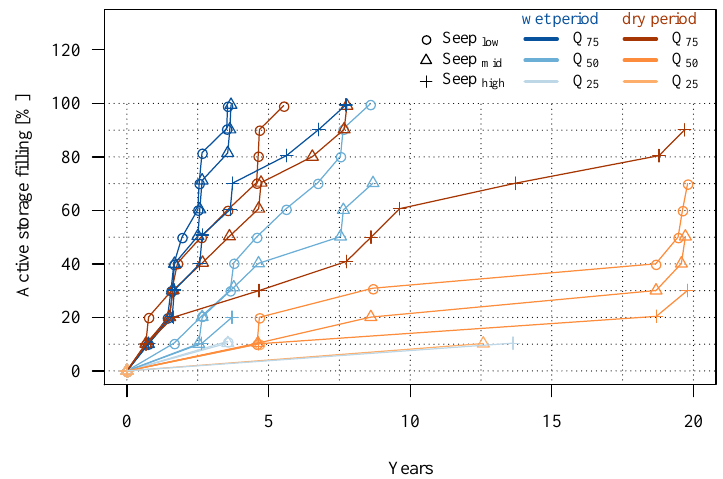
Figure 5. Time required to fill the active storage of the Grand Ethiopian Renaissance Dam (GERD) for different filling